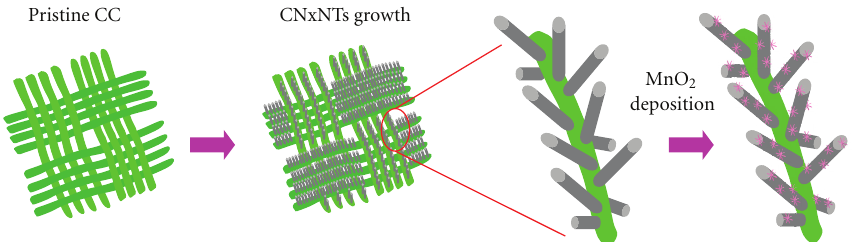
Figure 1: (a) Schematic diagram for fabrication of MnO 2 /CNxNTs/CC hybrid electrode.